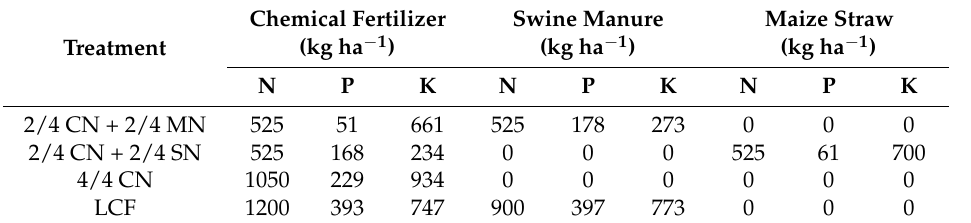
Table 1. Annual NPK input of all treatments from 2009 to 2018.